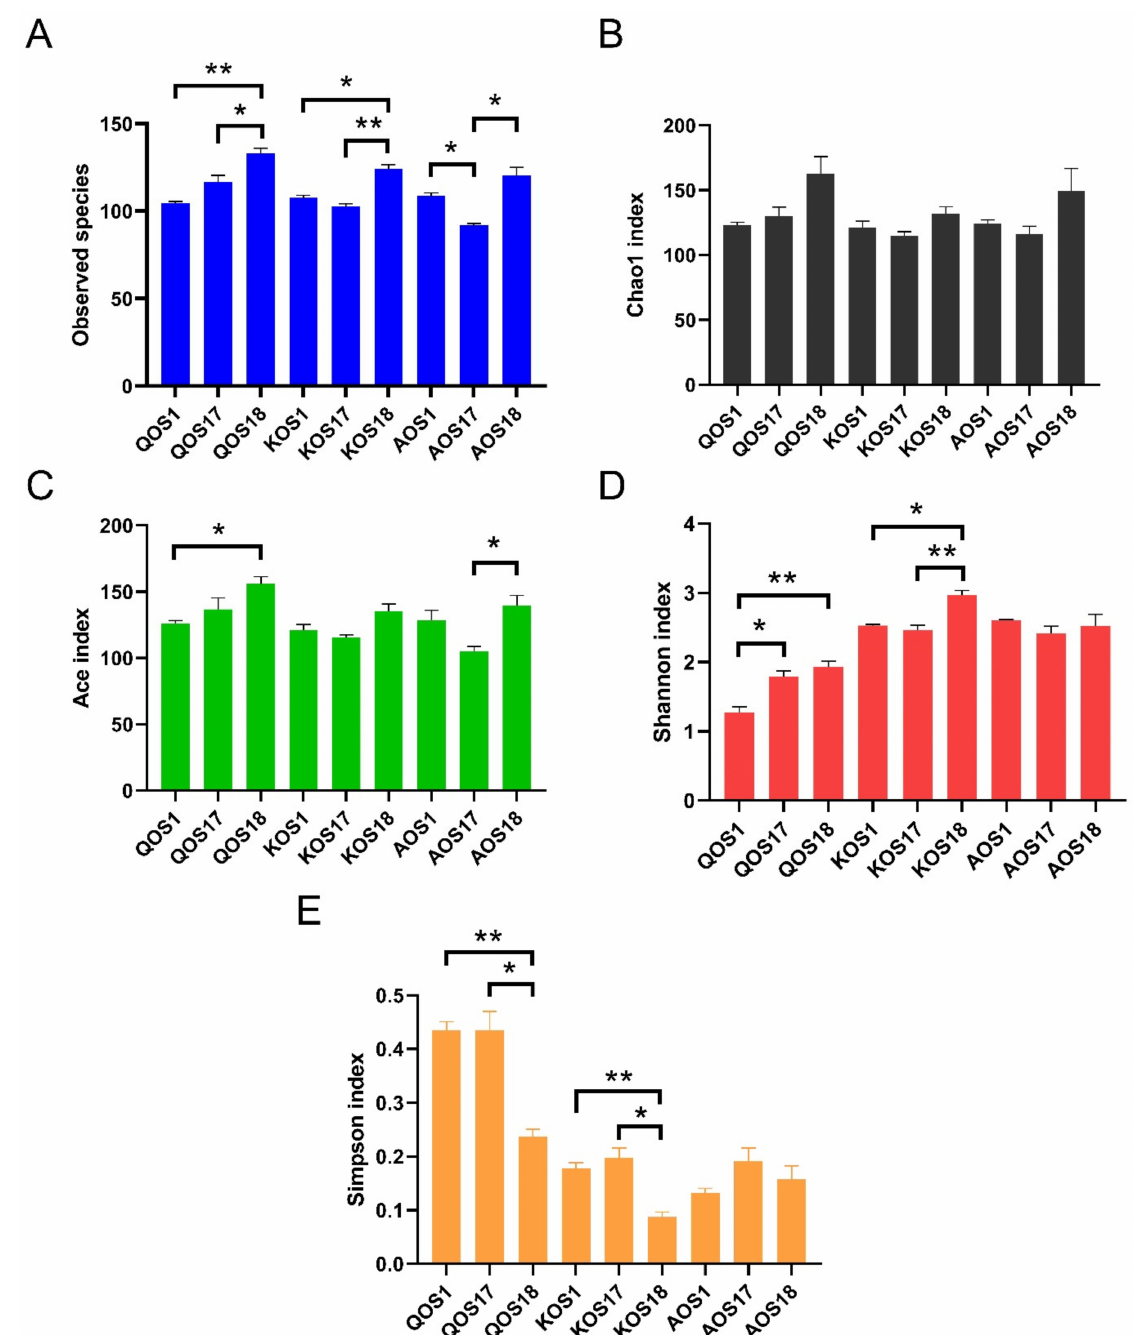
Figure 2. The α − diversity analysis of the gut microbiota. Observed species ( A ), Chao1 index ( B ), Ace index ( C ), Shannon index ( D ), and Simpson index ( E ). QOS1 denotes fermentation of QOS by gut microbiota F1. QOS17 denotes fermentation of QOS by gut microbiota F17. QOS18 denotes fermentation of QOS by gut microbiota F18. Each fermentation group has three replicates. KOS and AOS were labeled using the same format. Data are expressed as mean ± SEM. Statistical analysis was performed using ANOVA with post hoc Tukey’s multiple comparisons test. * p < 0.05, ** p <